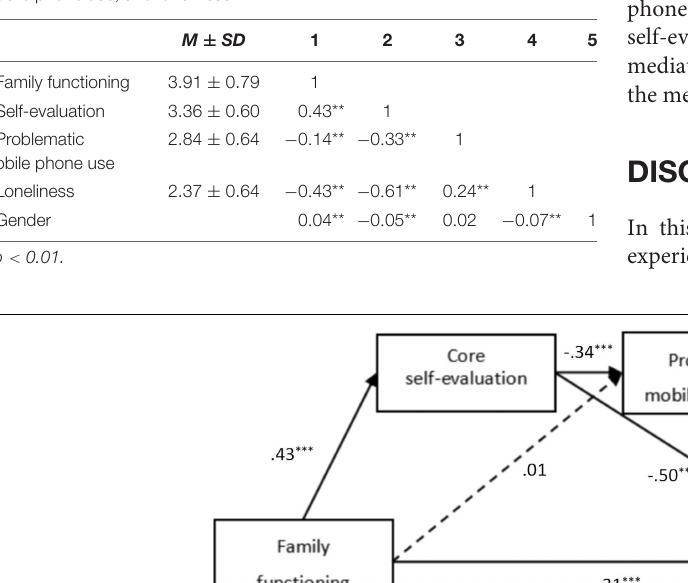
TABLE 1 | Correlation analysis of family functioning, self-evaluation, problematic mobile phone use, and loneliness.